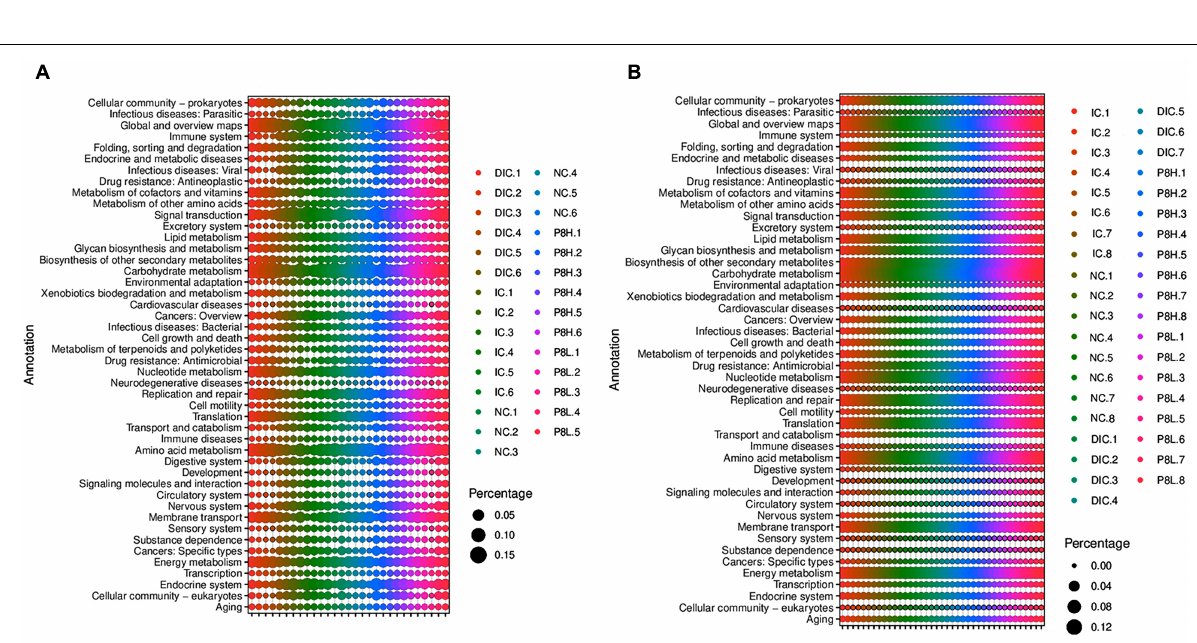
Frontiers in Microbiology |